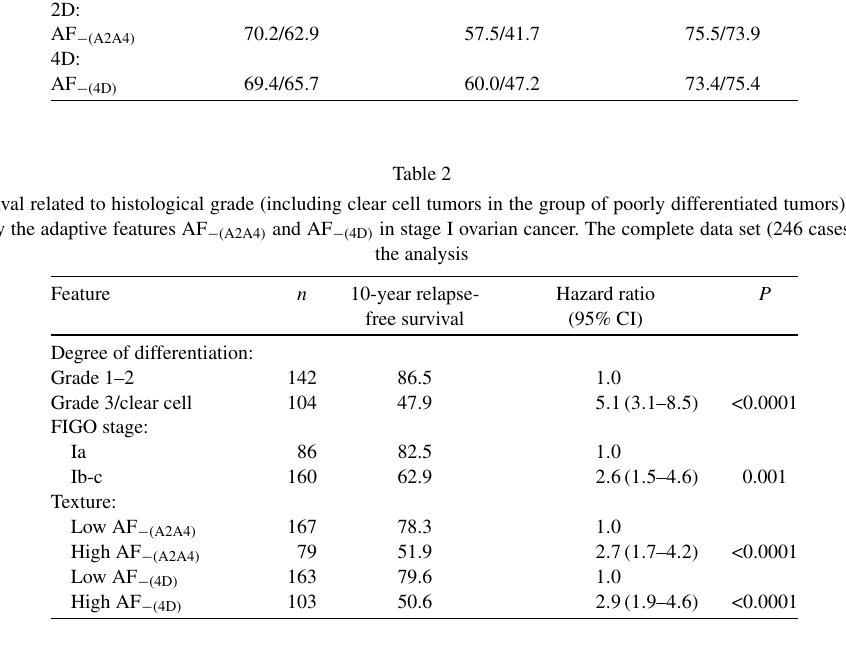
Significant variables for survival in multivariate analysis including histological grade (including clear cell tumors in the group of